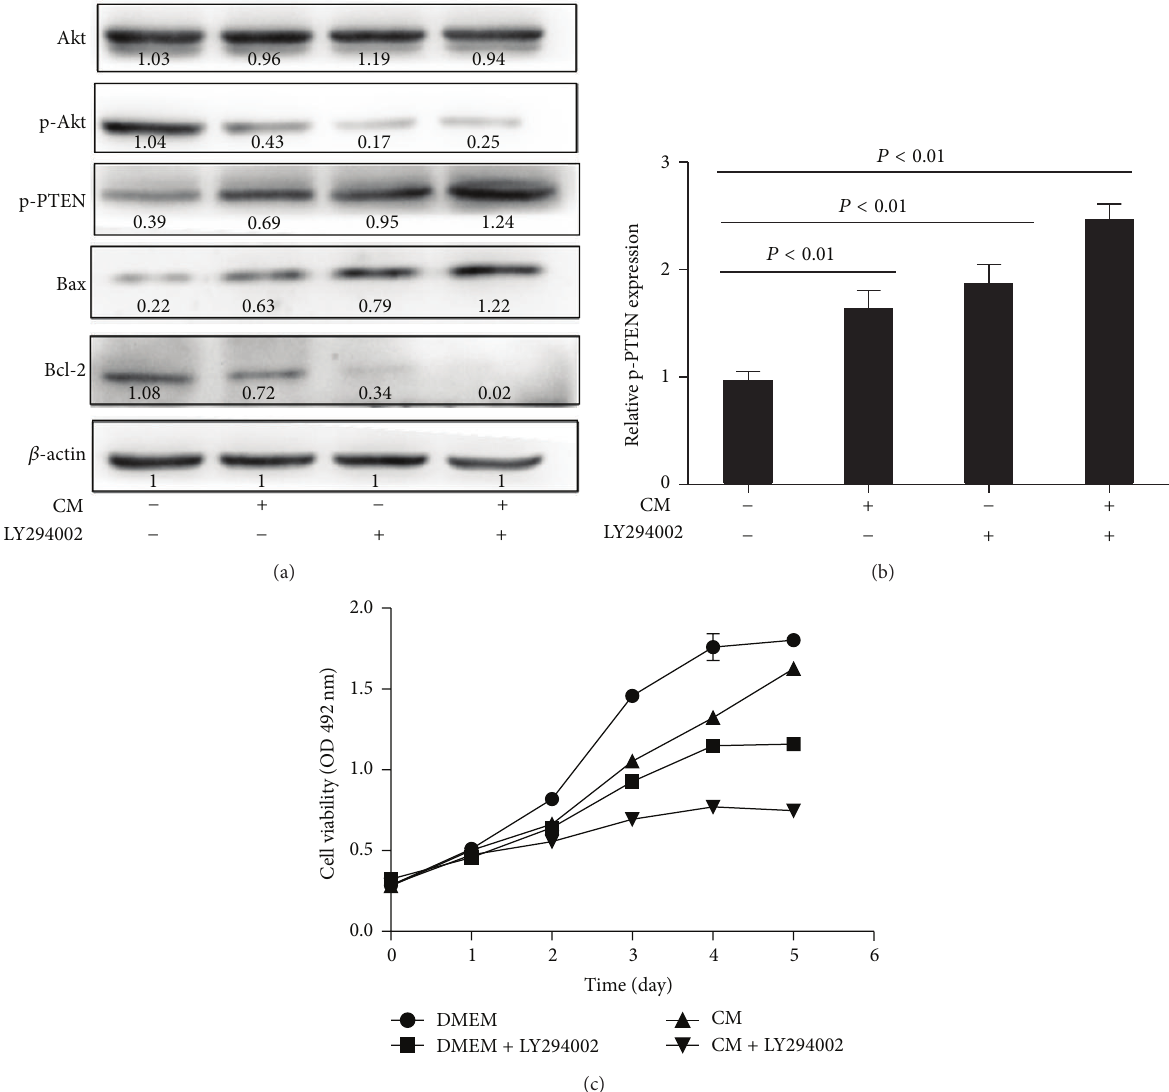
Figure 7: (a) T24 cells was treated with 20 𝜇 M PI3 kinase inhibitor LY294002 for 60min and then with ADSC-CM or DMEM for another 24 h. LY294002 decreased the protein levels of Bcl-2 and p-Akt and increased the protein levels of Bax and p-PTEN. Data presented in (b) are the mean ± SD of three independent experiments ( ∗ 𝑃 < 0.05 ). LY294002 enhances ADSC inhibition of T24 cells growth. T24 cells were treated with ADSC-CM, 20 𝜇 M LY294002, or both for 24 h. Cell viability was determined by the MTS assay (c). Data shown are the mean ± SD of three independent